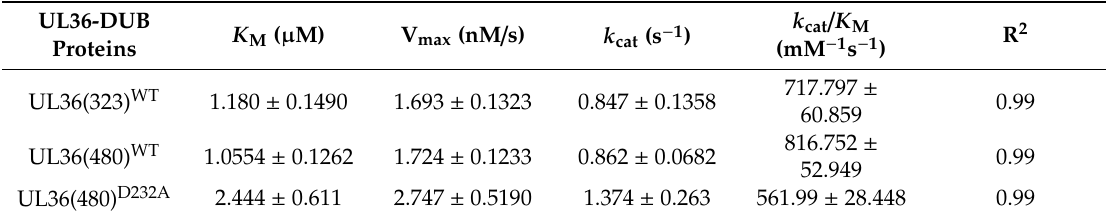
Table 1. A summary of results in kinetic analysis of